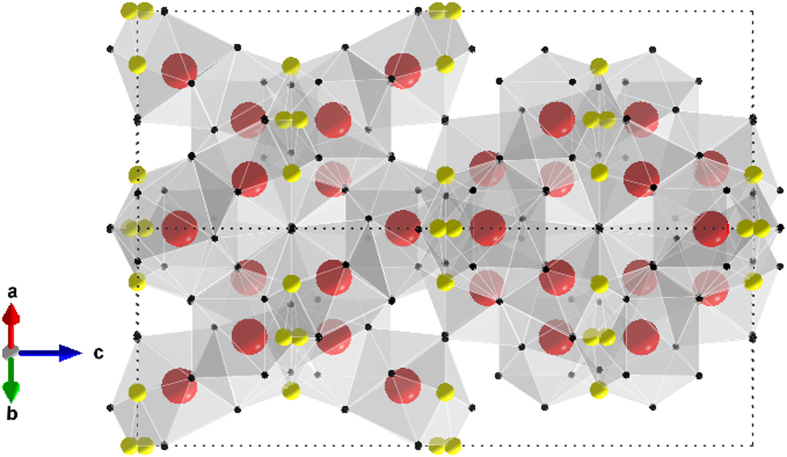
The tetragonal crystal structure of Y5Rh6Sn18.The red spheres (largest) are Y, black spheres (smallest) are Sn, and the yellow spheres are Rh.